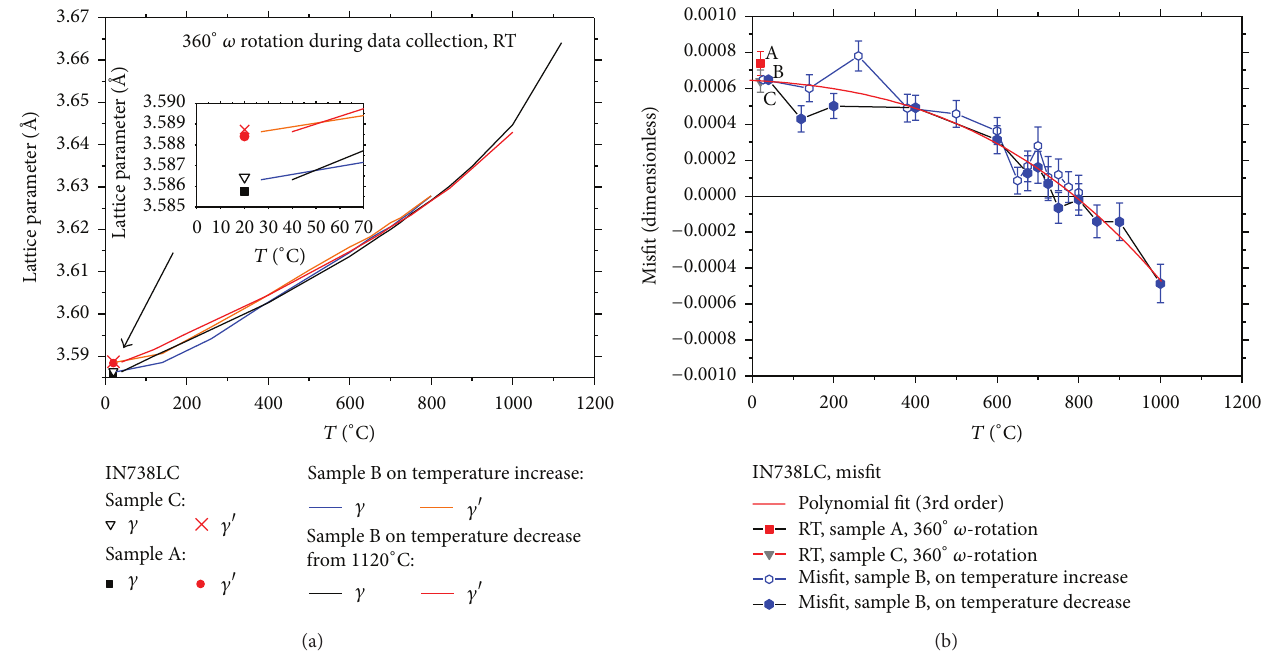
Figure 5: (a) Evolution of lattice parameters of 𝛾 and 𝛾 󸀠 in IN738LC superalloy with temperature and (b) temperature dependence on the